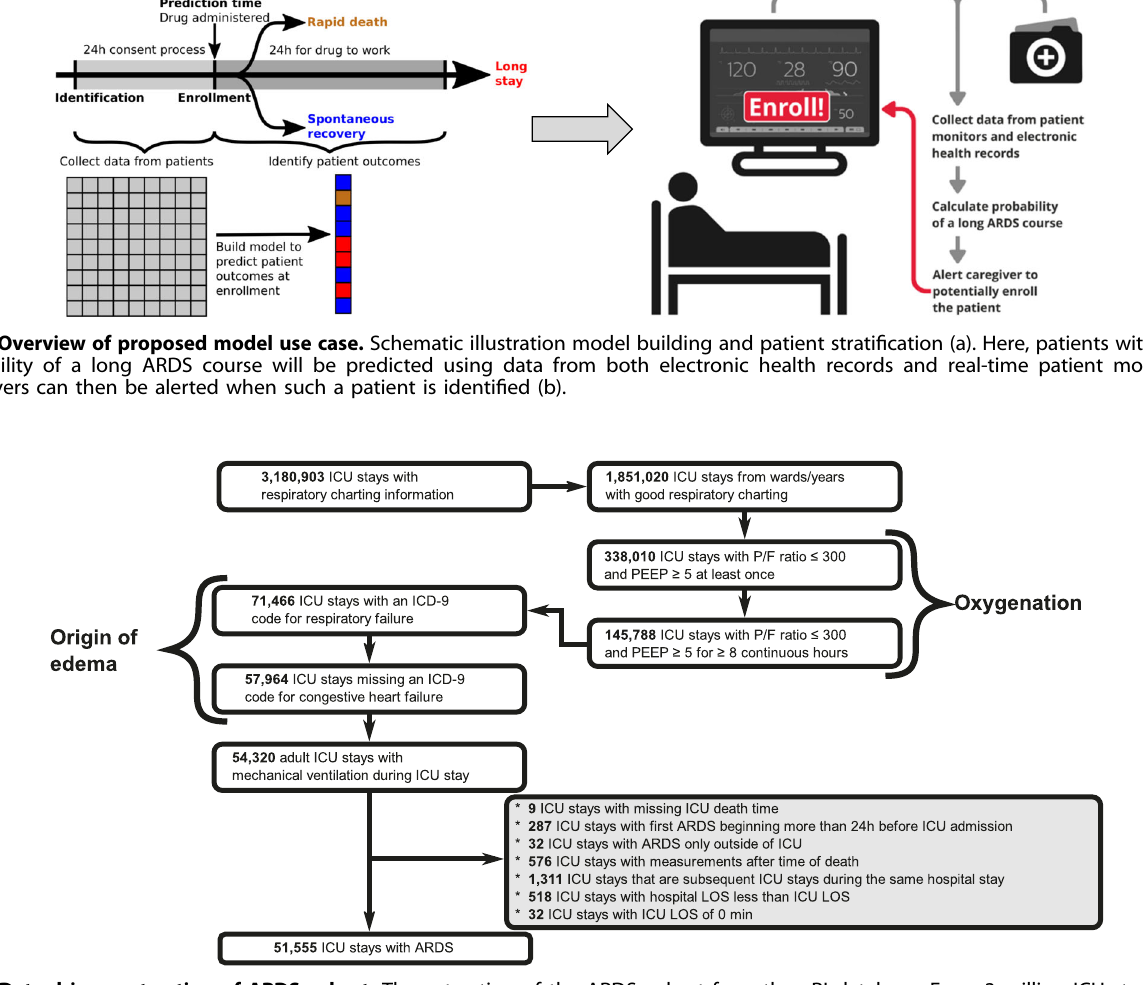
Fig. 2 Data-driven extraction of ARDS cohort. The extraction of the ARDS cohort from the eRI database. From 3 million ICU stays in the database, we retained only mechanically-ventilated adults with poor oxygenation (de fi ned as P/F ratio ≤ 300 and PEEP ≥ 5 for at least 8 h) and whose edema was due to respiratory failure rather than congestive heart failure, as captured by ICD-9 codes recorded during ICU